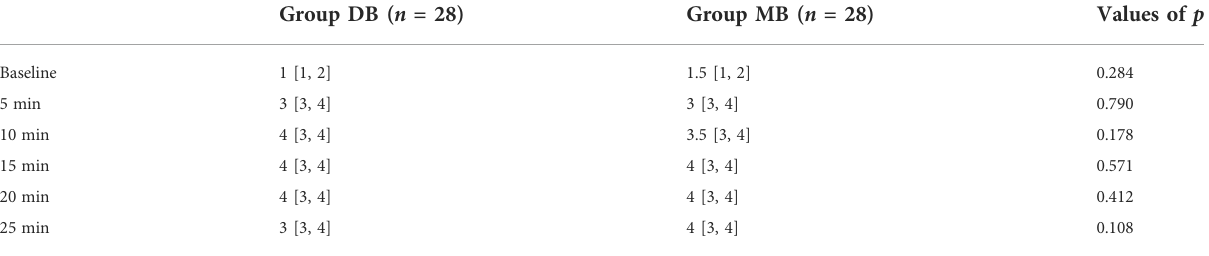
TABLE 2 Ramsay sedation scales of the two study